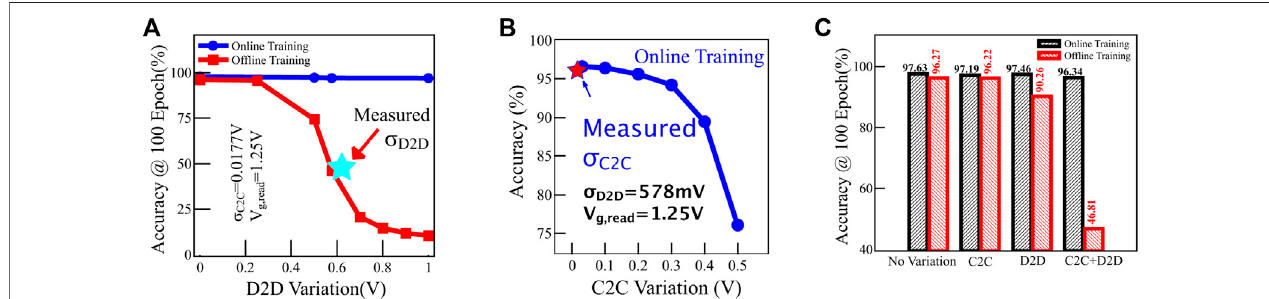
FIGURE 8 | (A) Impact of device-to-device variations is signi fi cant only for of fl ine-trained neural networks. (B) Impact of cycle-to-cycle variations cannot be compensatedbyonlinetraining.Hardwaresuggestsitseffectisnegligible. (C) Effectofvariationsontrainingaccuracyisminimalforhardware-calibratedvariabilityforthe online training scenario but is signi fi cant for the of fl ine training scenario.